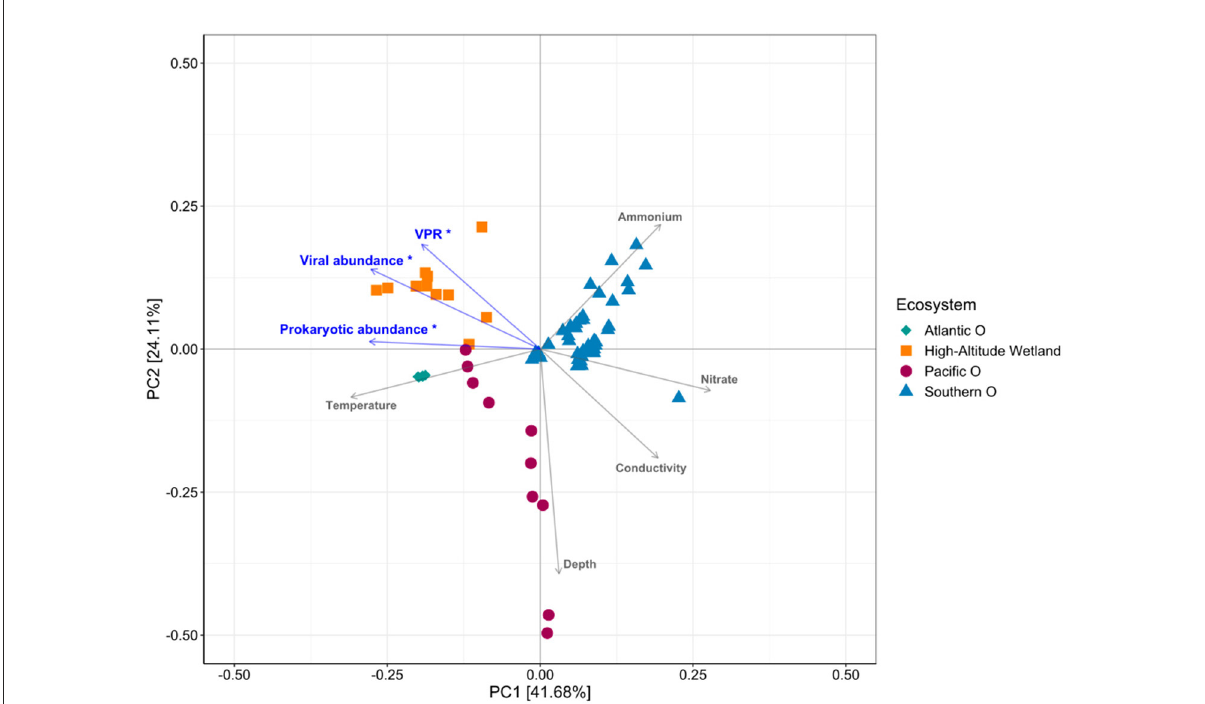
FIGURE8 Principal component analysis showing the relationship between environmental variables and VPR values potentially relevant in the different ecosystems